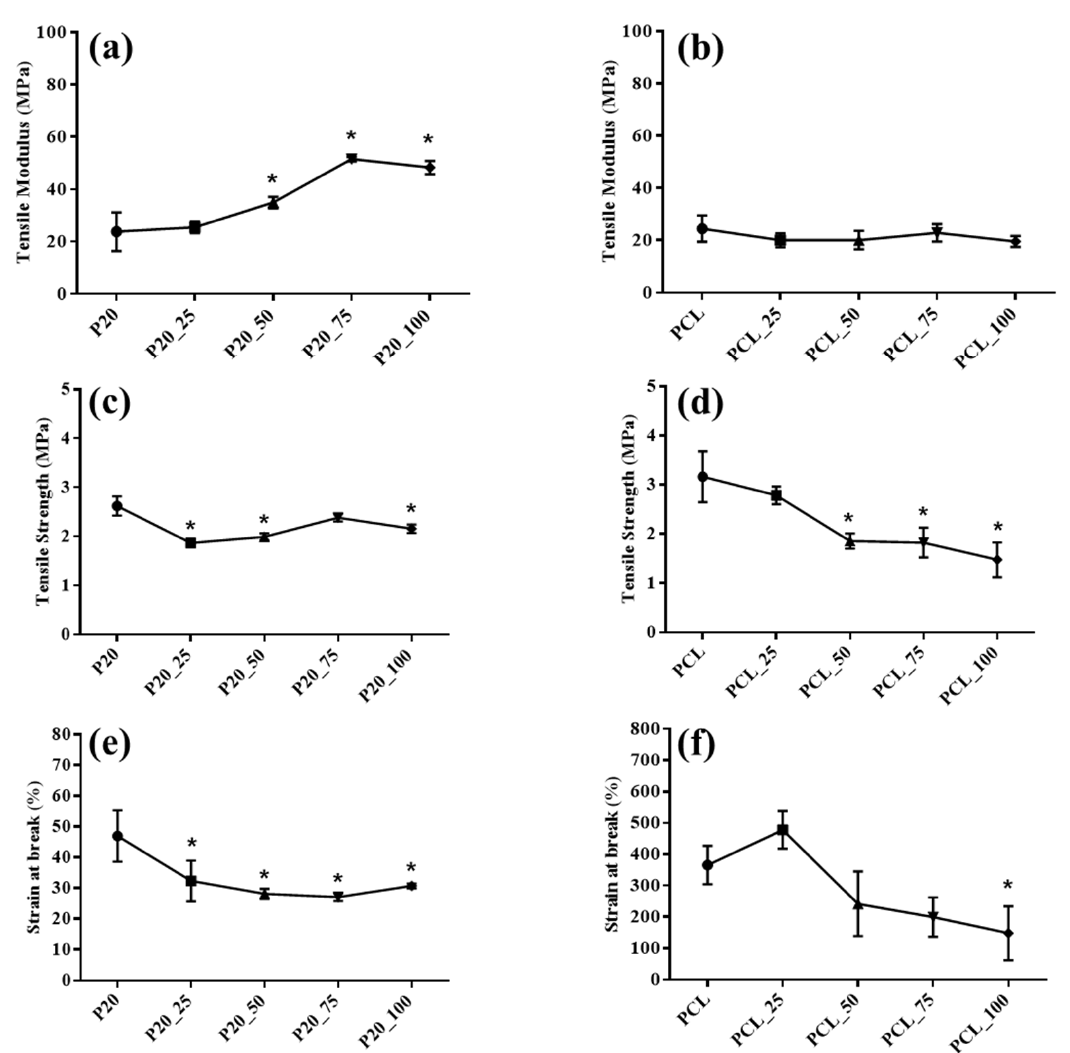
Figure 3. Influence of cefazolin concentration in the ORC/PCL bilayered composite and PCL on tensile properties: ( a ) Tensile modulus of cefazolin loaded ORC/PCL bilayered composite; ( b ) tensile modulus of cefazolin loaded PCL; ( c ) tensile strength of cefazolin loaded ORC/PCL bilayered composite; ( d ) tensile strength of cefazolin loaded PCL; ( e ) tensile strain at break of cefazolin loaded ORC/PCL bilayered composite; ( f ) tensile strain at break of cefazolin loaded PCL. Data are expressed as mean ± standard deviation (SD). Statistical significance between cefazolin loaded samples versus control (P20 or PCL) is indicated as * ( p < 0.05).